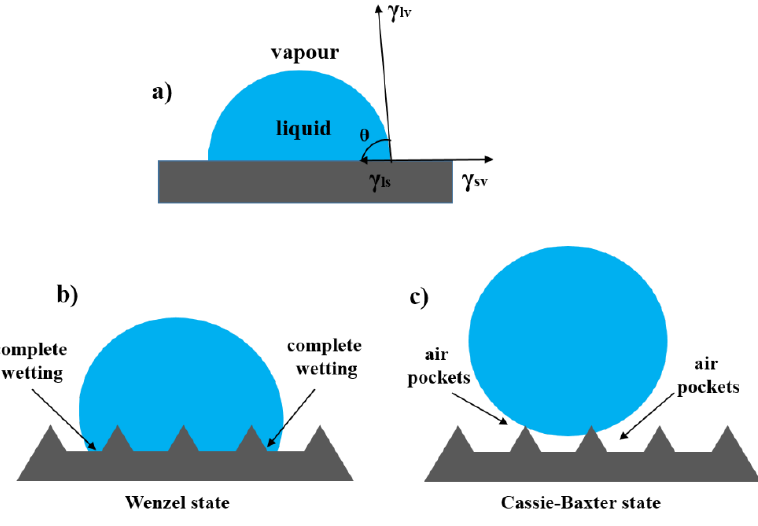
Figure 6. Schematic diagrams of a liquid droplet on various surfaces. ( a ) Flat surface, ( b ) Wenzel state, ( c ) Cassie–Baxter state. state, ( c ) Cassie–Baxter